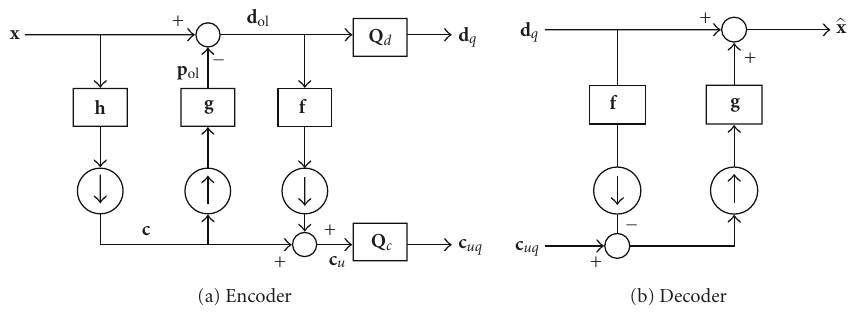
Figure 5: Lifted-pyramid structure with an update